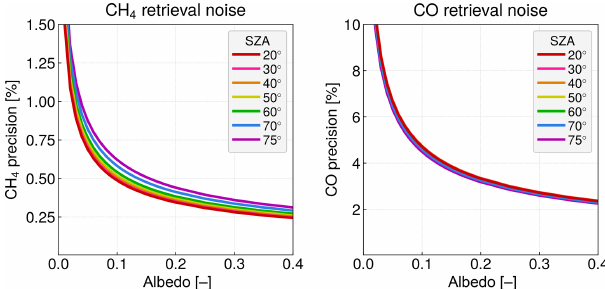
Figure 3. TROPOMI/WFM-DOAS CH 4 and CO relative retrieval noise for US Standard Atmosphere